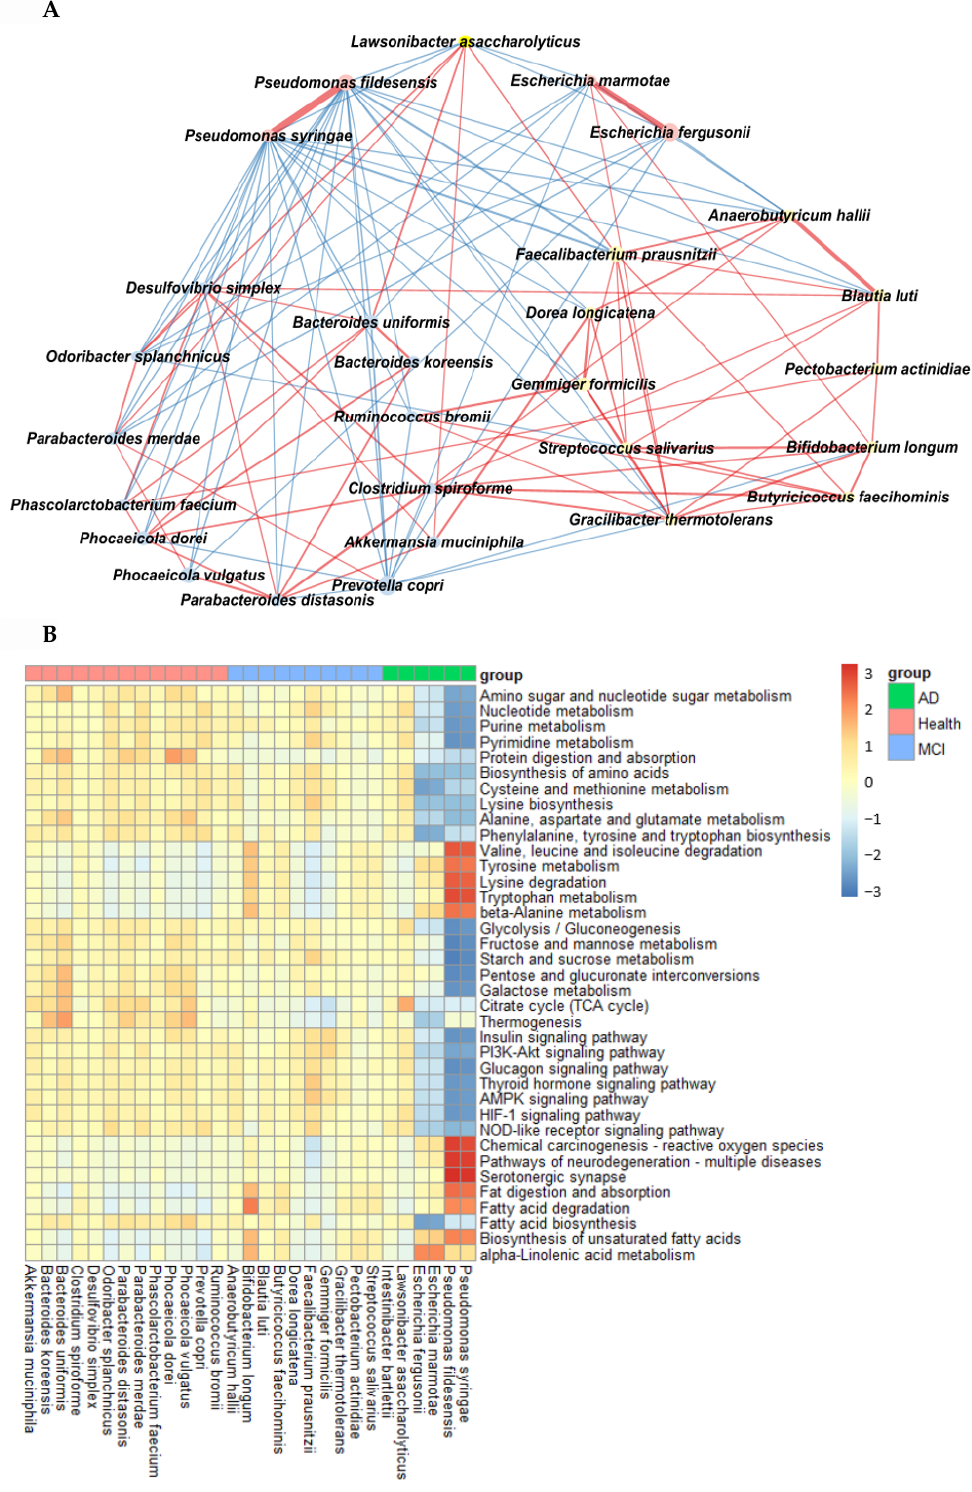
Figure 4. Network analysis and metagenome functions of the primary bacteria among the healthy, MCI, and AD groups ( A ). The network of the primary bacteria among the primary bacteria, according to the healthy, MCI, and AD groups in the participants with enterotype Bacteroides. Red and blue lines indicated positive and negative correlations with the Pearson correlation coefficient >0.1, respectively. ( B ) Metagenome functions of the primary bacteria in human